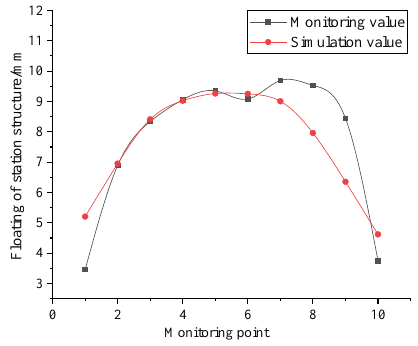
Figure 10. South side deformation curve.